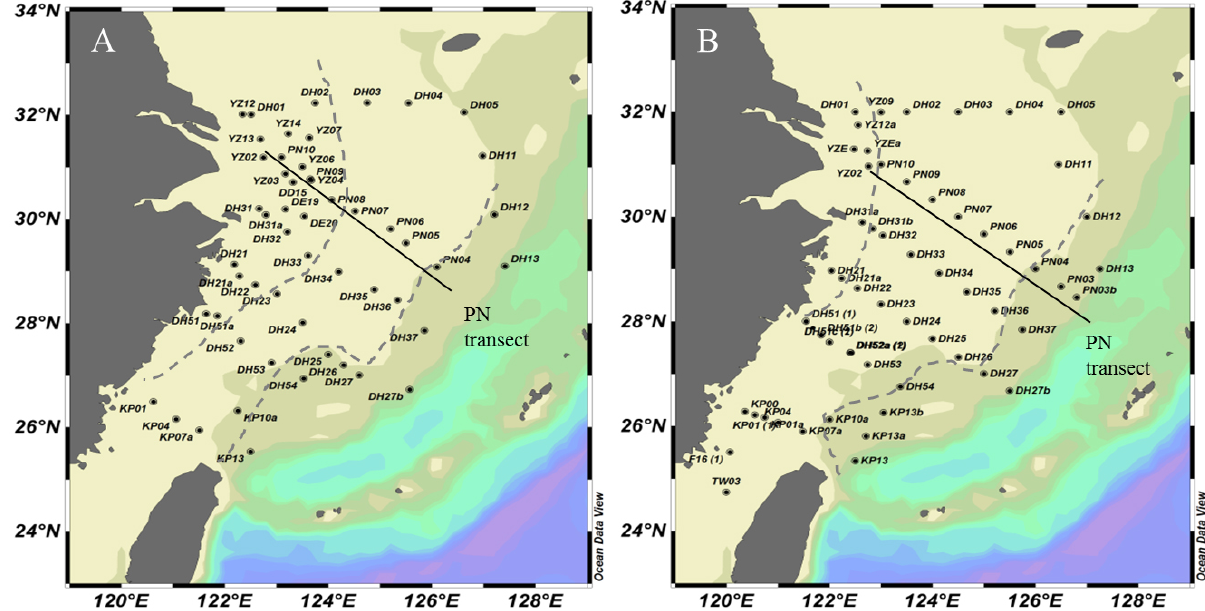
Fig. 1. Location of investigated stations in (A) summer and (B) winter. Plume, transitional, and Kuroshio regions were divided by the grey dotted lines. The PN transect is labeled as a black